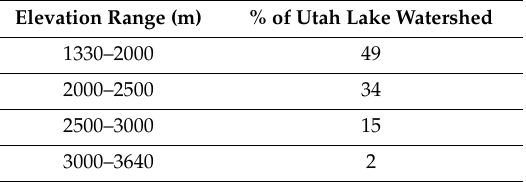
Table 2. Percentages of surface area of the Utah Lake watershed located at di ff erent elevation